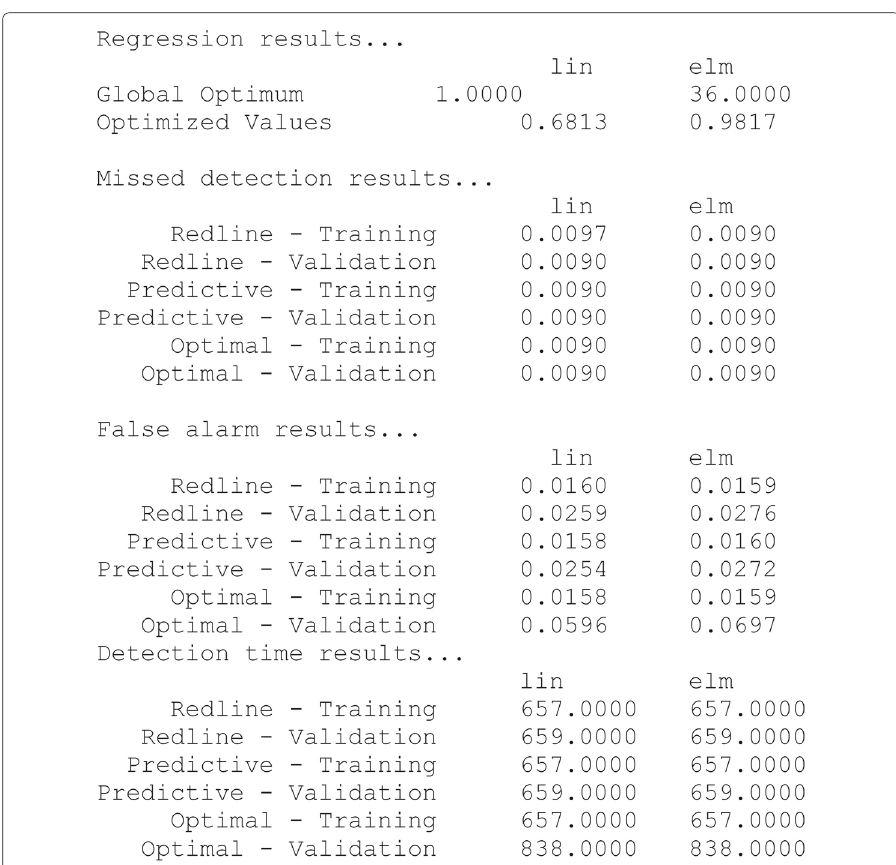
Fig. 4 ACCEPT results on MDR, FAR and DT for fault case “Open-windows-during-night”. Regularization coefficient is 1.0 and number of hidden neurons is 36. Missed Detection Rate (MDR) is shown first, then